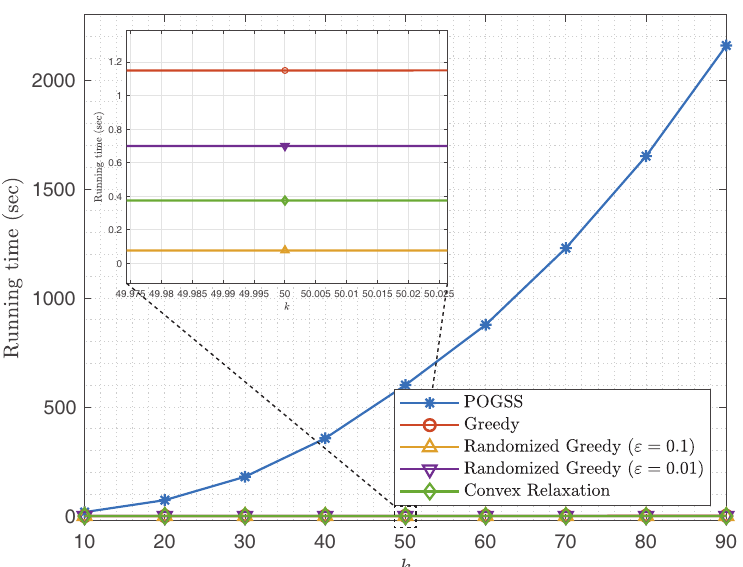
Figure 6. Running time v.s. k for non-bandlimited graph signals obtained on ER graphs. We also provide a visual demonstration for our method. We use the stanford bunny data [6] to obtain the graph. The nodes are scanned from a 3D model, and the edges are obtained by connecting each node with its’ four nearest neighbors. The smooth graph signal is first sampled from a Gaussian distribution, and then filtered by a heat diffusion low-pass filter [24]. The resulting graph Fourier coefficients after filtering are ˆ λ = h ( λ ) = exp ( − t λ ) , i i i where t is the scaling parameter and is set to 10 in our experiment. As displayed in Figure 7a is the original smooth graph signal with Gaussian noise, the noise power is σ 2 = 0.01. There are n = 453 nodes in the original graph, and we sample a subset with k = 300 nodes by using POGSS to obtain Figure 7b, note that all of the edges are from the original graph. Figure 7c illustrates the optimally recovered graph signal by using (3), and the corresponding reconstruction error is MSE (cid:63) S =